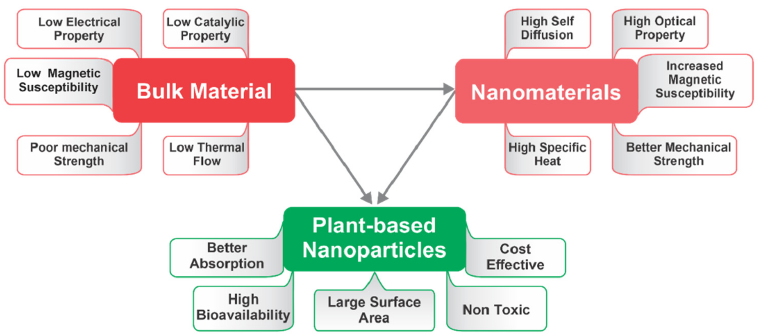
Figure 3. Diagrammatic representation of numerous properties of bulk material, nanomaterials, and plant-based nanoparticles (PDMNPs).